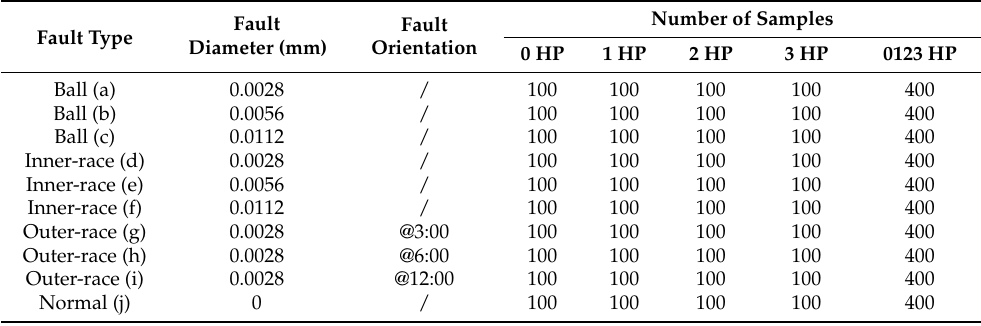
Table 1. One-dimension original signal data set partitioning.